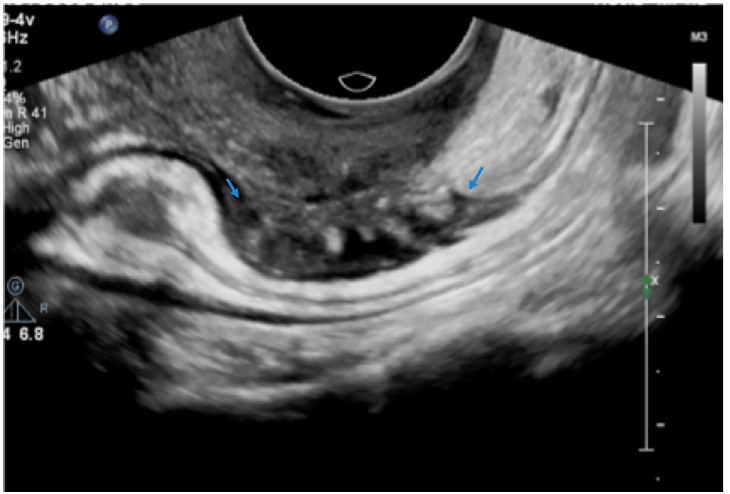
Fig 4. USTVBP image showing a longitudinal section of the rectosigmoid segment. Deep endometriosis nodule in the anterior wall with involvement up to the outer muscular layer (blue arrows).